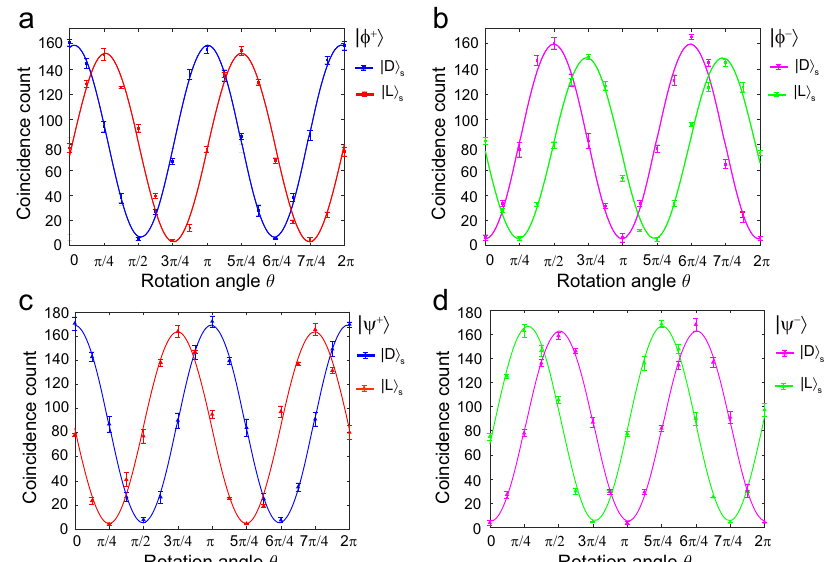
Fig. 5 Two-photon interference fringes of the OAM entangled states. a Interference fringes for the state ϕ þ j i . b Interference fringes for the state ϕ (cid:3) j i . c Interference fringes for the state ψ þ j i . d Interference fringes for the state ψ (cid:3) j i . Signal photons are projected onto D j i ¼ 1 ffiffi 1 ffiffi p ð 1 j i þ (cid:3) 1 j iÞ and L j i p ð 1 j i þ i (cid:3) 1 j iÞ , while idler photons are projected onto θ j i s 2 2 Each coincidence count is measured for 10 s. The error bars represent one standard deviation.